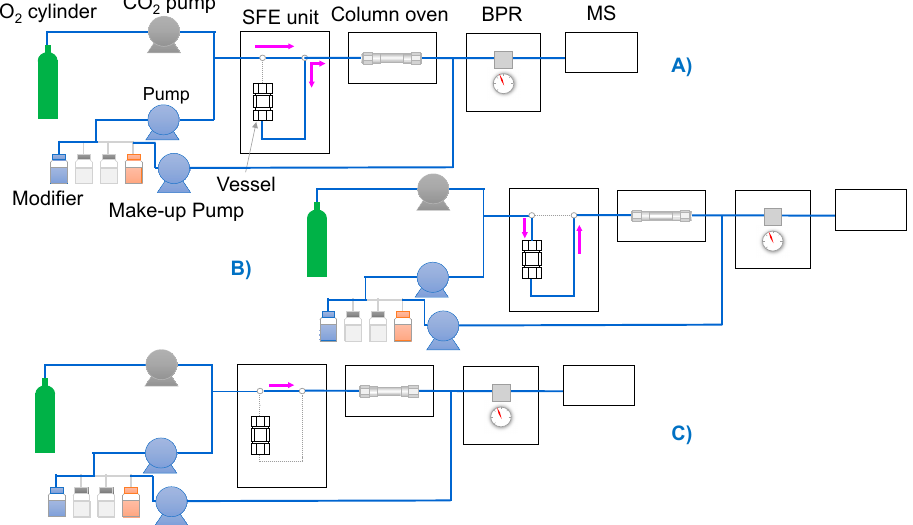
Figure 2. Scheme of the supercritical fluid extraction-supercritical fluid chromatography-mass spectrometry (SFE-SFC-MS) system: ( A ) Static extraction mode, ( B ) Dynamic extraction mode, ( C ) Analysis mode. Reprinted with permission from [17].